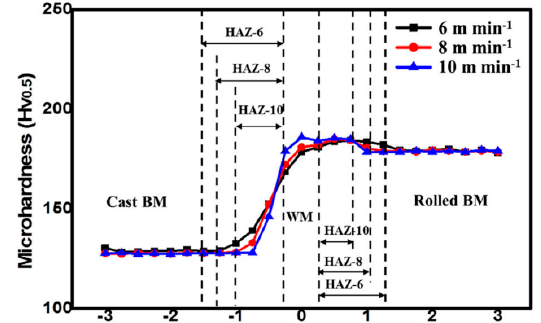
Figure 6. Microhardness profile of the dissimilar weld (Reproduced from [57], with permission from Taylor & Francis, 2019).